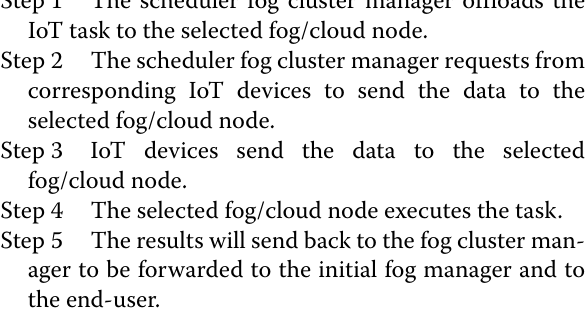
IoT tasks are arriving into the queue of fog nodes with an arrival rate λ that follows the Poisson distribution process [35]. The accumulated arriving tasks during δ s are taken into account using a priority queue, i.e., the delay-sensitive tasks are set at the front of the